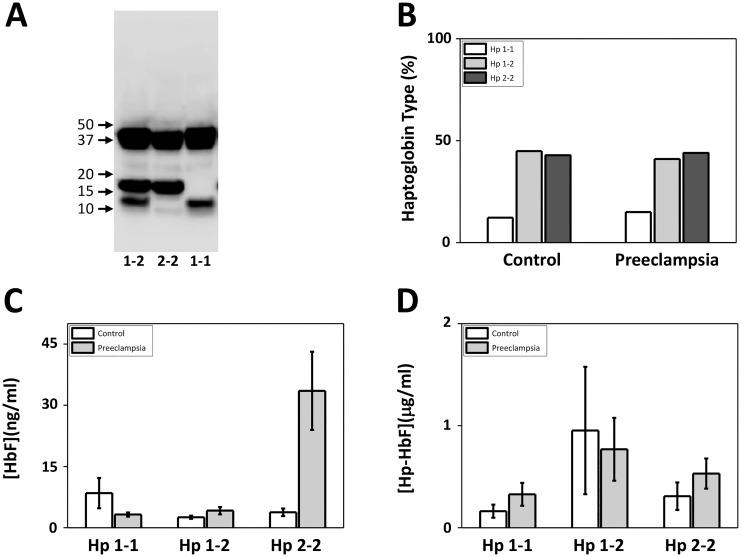
Correlation between Hp phenotype, cell-free HbF- and Hp-HbF concentration.Hp-phenotypes (1–1, 1–2 or 2–2) were investigated in plasma using SDS-PAGE and Western blot with anti-Hp antibodies as shown in the three patient examples (A) as described in Materials and Methods and the distribution of the different isoforms are presented as mean percentage of women with Hp 1–1, 1–2 and 2–2 for respective group (B). The plasma concentration of cell-free HbF (C) and Hp-HbF (D) are shown separately in patient samples with each Hp phenotype (Hp 1–1, 1–2 and 2–2). Results are presented as mean percentage of respective Hp phenotype (Hp 1–1, 1–2 and 2–2) in B. Results are presented as mean ± SEM plasma concentration of cell-free HbF and Hp-HbF in C and D.